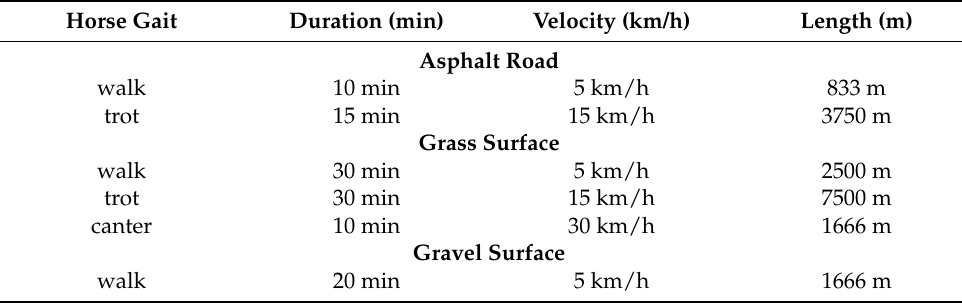
Table 2. The description of the horse combined driving training (day 56). Horse